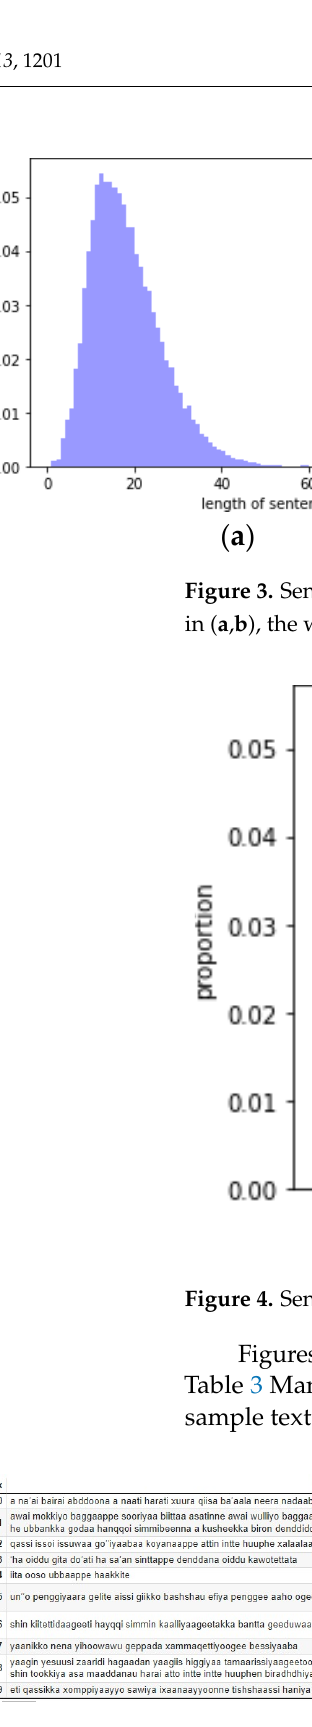
Figure 6. Sample texts from Wolaytta monolingual dataset. Table 3. Manually translated sample text for monolingual text Figure 6. Wolayta Monolingual Equivalent Translation (Manually Translated) So that the language and people put a victim one another, which resulted in the growth and death of it she is saying that go to home whom not cleaning her mother-in-law dirty home Minute or idea collection Not only the sign of language but also the message it conveys the rude father who saw it went to his home and said to his careless wife that our son we let him to keep cattle who stole black piece of powder and laid filling his mouth different kinds of Wolaytta literature answer as indicated in the paragraph it must be based on the knowledge level of language reading culture that may or may not possible 5. Methodology